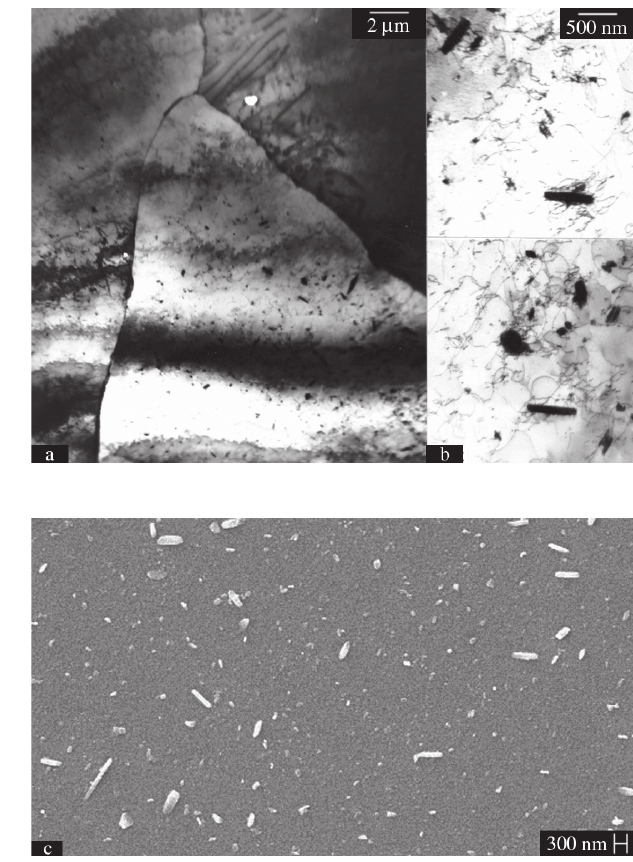
Figure 3. TEM and SEM images, respectively, showing the presence of both elongated and fine heterogeneous sized intragranular precipitates in the ISAMW condition (cross section of the weldment, PWHT